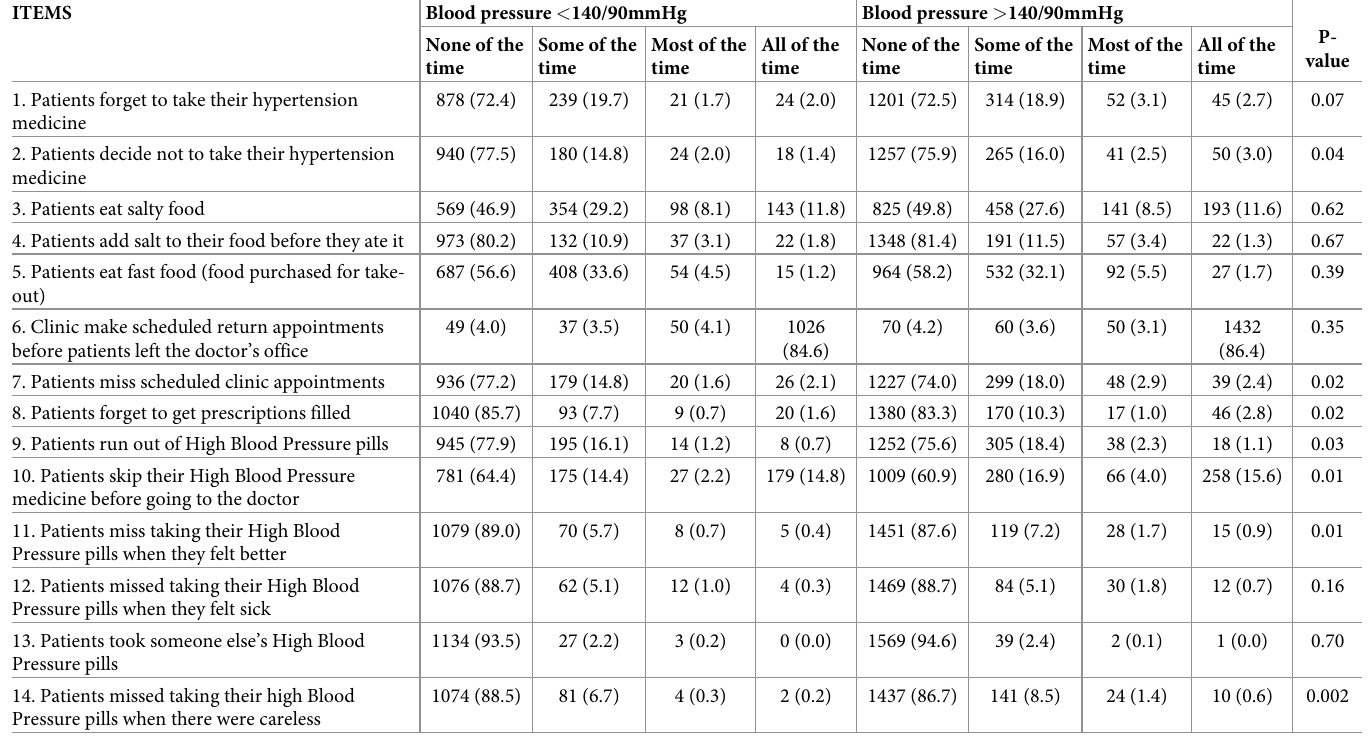
Table 2. Responses to the Hill-Bone compliance to high blood pressure therapy